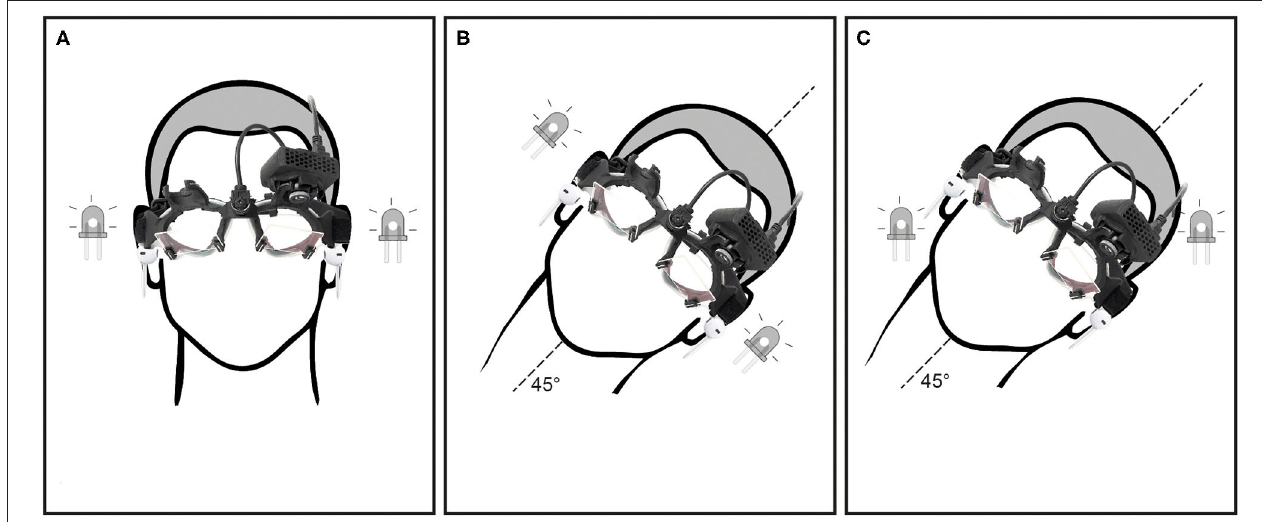
FIGURE 1 | Showing different head and LED positions: (A) head upright, LED positioned for horizontal eye movements in the orbit, (B) head tilt 45 ◦ to the left, LED positioned for horizontal eye movements in the orbit and (C) head tilt 45 ◦ to the left, LED positioned for oblique (combined horizontal and vertical) eye movements in the